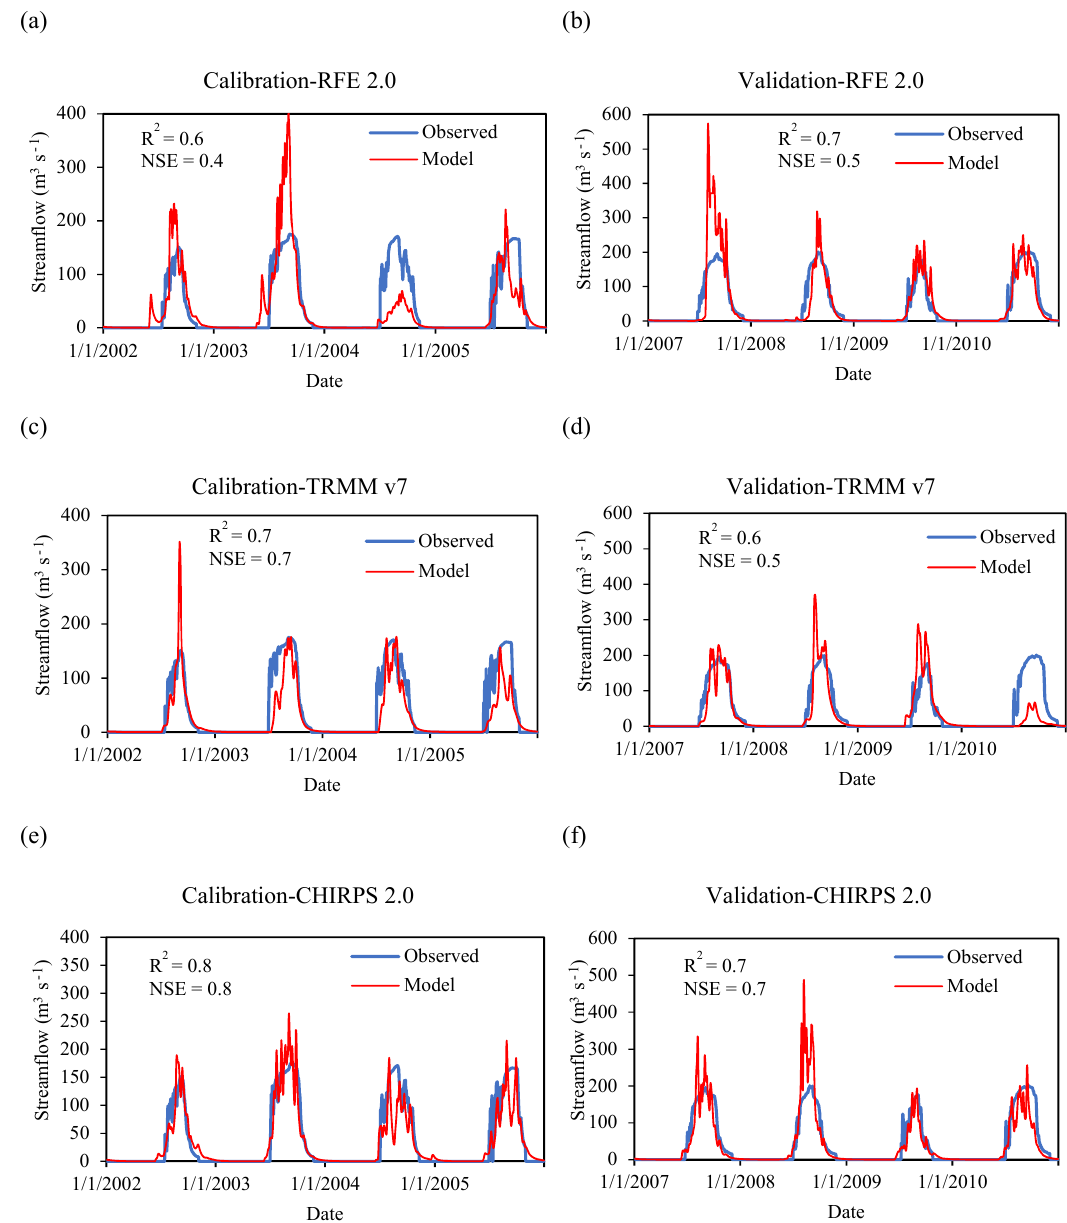
Figure 7. Calibration and validation results at Al Hawata station on Rahad River (a) and (b) for RFE, (c) and (d) for TRMM and (e) and (f) for